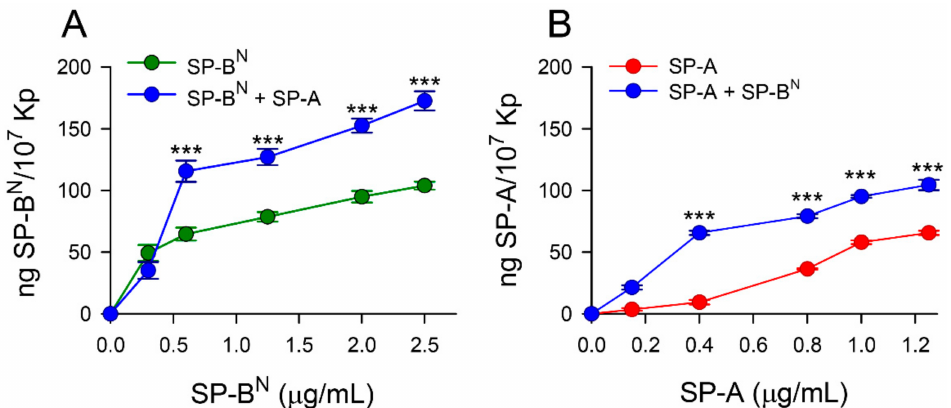
Figure 4. Binding capacity of SP-A and/or SP-B N to non-capsulated deep rough K. pneumoniae strains (Re-LPS Kp-CPS). ( A ) The concentration of biotinylated SP-B N associated with Re-LPS Kp-CPS was measured by a solid phase binding assay in the presence and absence of SP-A (10 µ g/mL). ( B ) Binding capacity of biotinylated SP-A to Re-LPS Kp-CPS in the presence and absence of SP-B N (10 µ g/mL). The results are the mean ± SD of three independent experiments. A value of *** p < 0.001 was obtained for the one-way ANOVA, followed by the general multiple-comparison Bonferroni